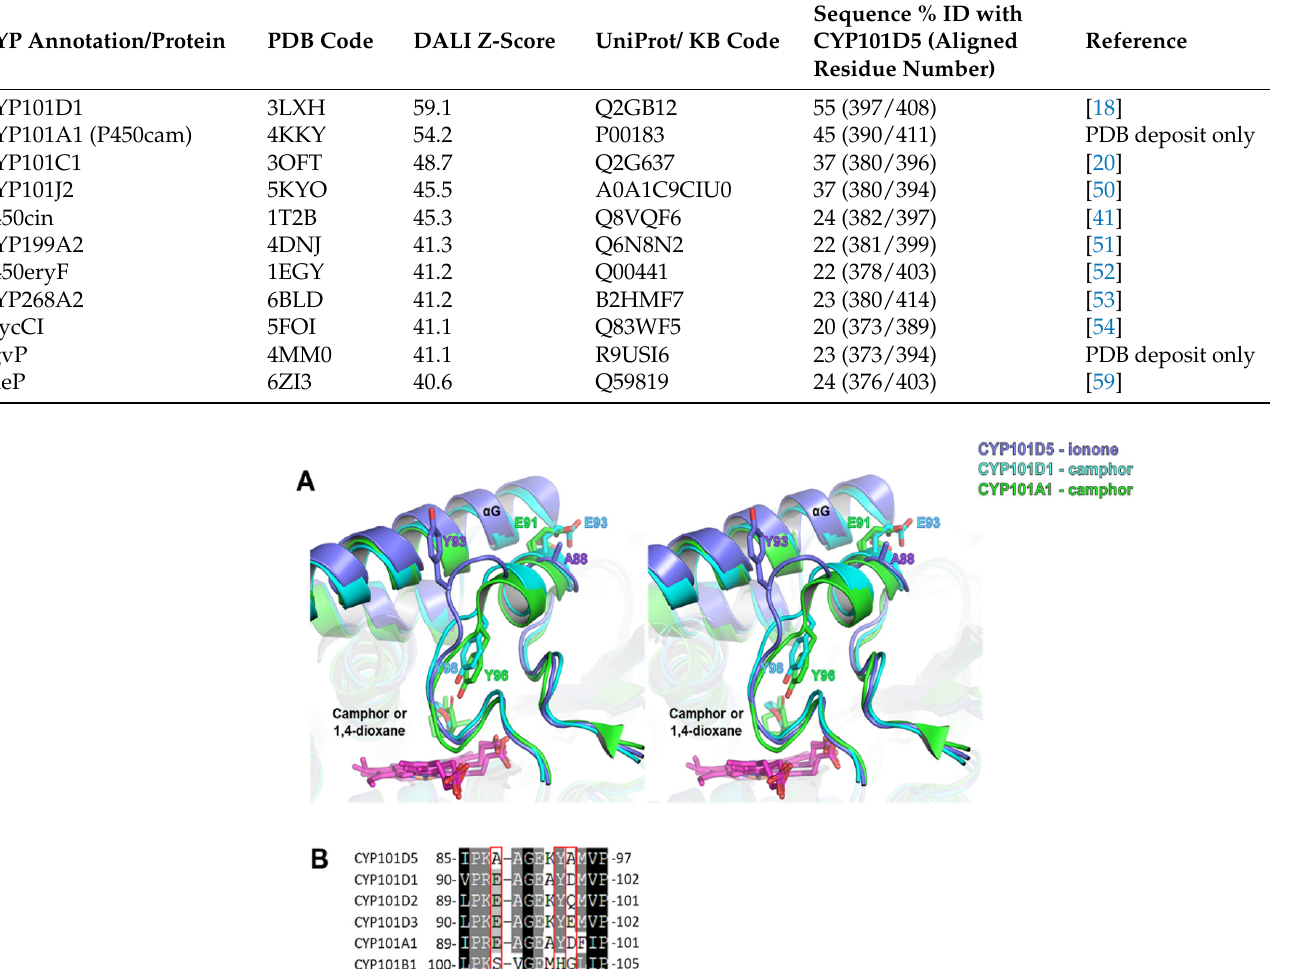
Figure 7. Substrate binding site of CYP101D5 and a comparison of residues consisting of the binding sites of three CYPs from the CYP101 family. The substrate binding site is denoted with a yellow dotted line. ( A ) Ionone-preferring CYPs; CYP101D5 and CYP101C1 are superposed. ( B ) Camphor- binding CYPs are aligned with the CYP101D5 structure. Key residues at the substrate binding site are highlighted with sticks. Residues from the energy-minimized structure of CYP101D5 are indi- cated and compared with the crystal structure.